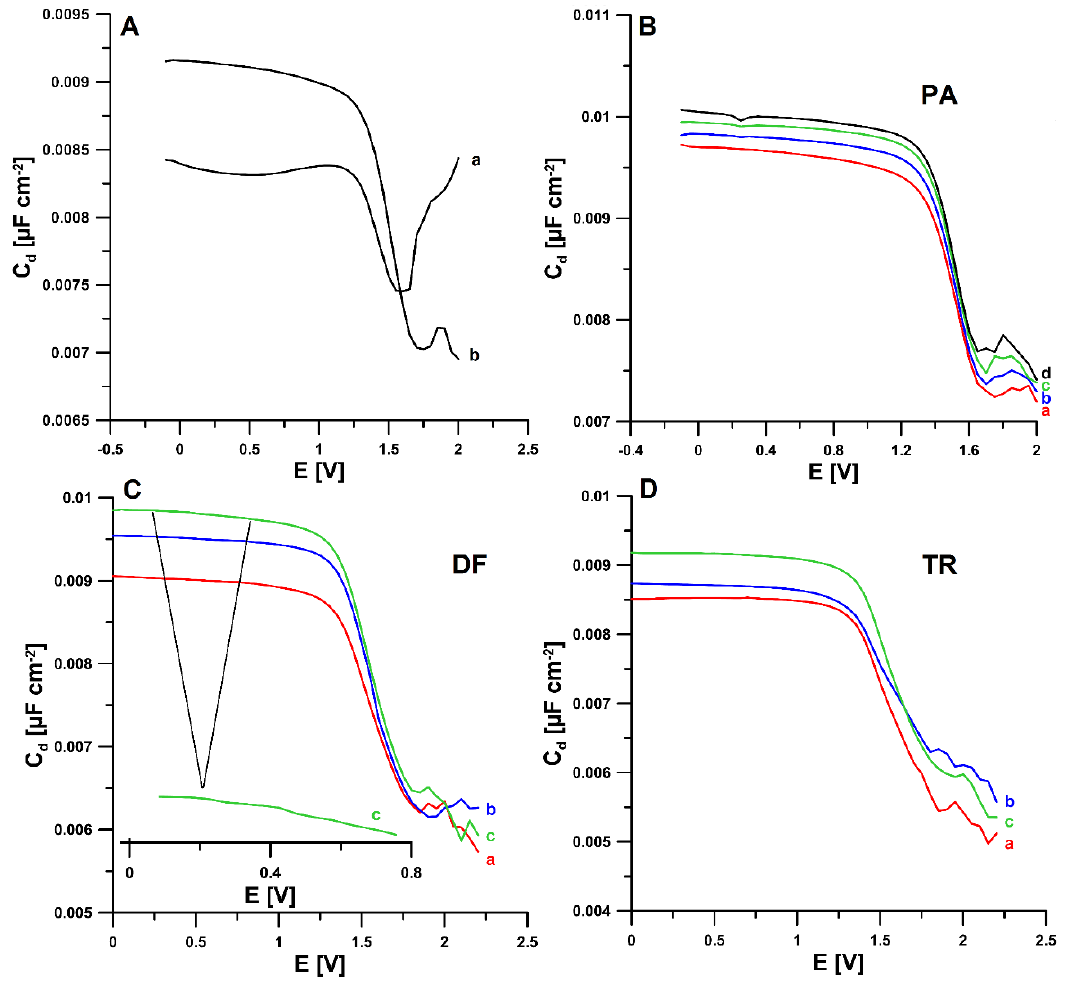
Figure 5. The differential capacity-potential curves of the double layer interface aSPCE/acetate buffer of pH = 4.0 ± 0.1 in the presence of: ( A ) 0 (a) and 15 (b) mg L − 1 SDS, ( B ) 15 mg L − 1 SDS and (a) 2 × 10 − 7 , (b) 2 × 10 − 6 , (c) 2 × 10 − 5 , (d) 2 × 10 − 4 mol L − 1 PA, ( C ) 15 mg L − 1 SDS and (a) 2 × 10 − 7 , (b) 2 × 10 − 6 , (c) 2 × 10 − 5 mol L − 1 DF, ( D ) 15 mg L − 1 SDS and (a) 2 × 10 − 7 , (b) 2 × 10 − 6 , (c) 2 × 10 − 5 mol L − 1 TR.